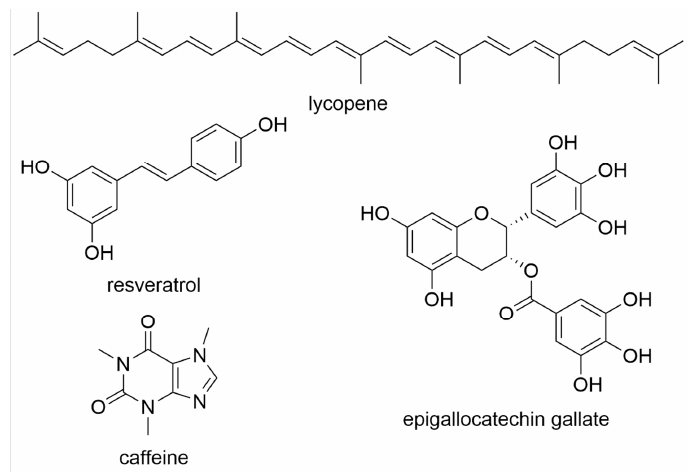
Figure 1. Natural products commonly found in food plants. 4. Boswellia/Frankincense Boswellia resin is a complex mixture of triterpenoids, mono-, sesqui-, and diterpe- noids, as well as polysaccharides, and is also known colloquially as Frankincense [61,62]. Frankincense is used in various cultures for religious purposes and for the treatment of various diseases [63]. Different types of Boswellia have been used in TCM as well as in Ayurvedic medicine. In Western medicine, frankincense is mainly used for inflammatory diseases (inhibition of 5-lipooxygenase and, thus, leukotriene biosynthesis), as well as for asthma. Boswellia dry extract is generally well tolerated and available as a medicinal sub- stance or as a dietary supplement [64,65]. Various preclinical studies have shown an anti-tumour effect of Boswellia in various cancer entities. The underlying mechanisms are complex. Boswellia inhibits various can- cer-associated signal transduction pathways, such as Signal transducer and activator of transcription 3 (STAT3), WNT/ β -catenin, AKT, extracellular signal-regulated kinases 1/2 (ERK1/2), nuclear factor ‘kappa-light-chain-enhancer’ of activated B-cells (NF- κ B), nuclear factor of kappa light polypeptide gene enhancer in B-cells inhibitor (I κ B), mammalian